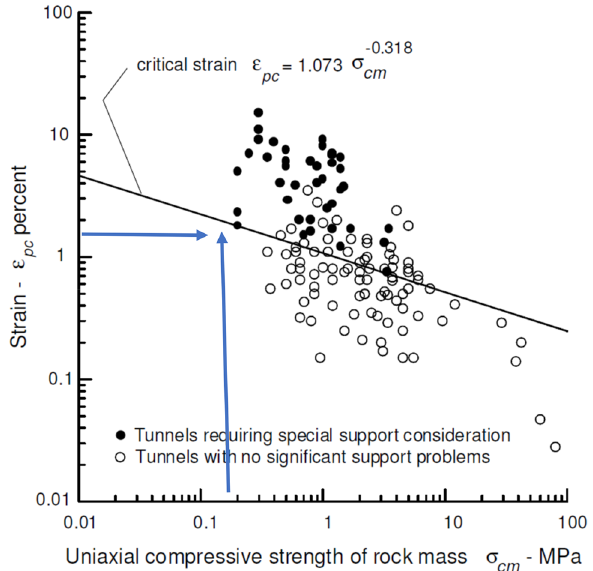
Figure 9. Strain for different rock mass strengths 5 .